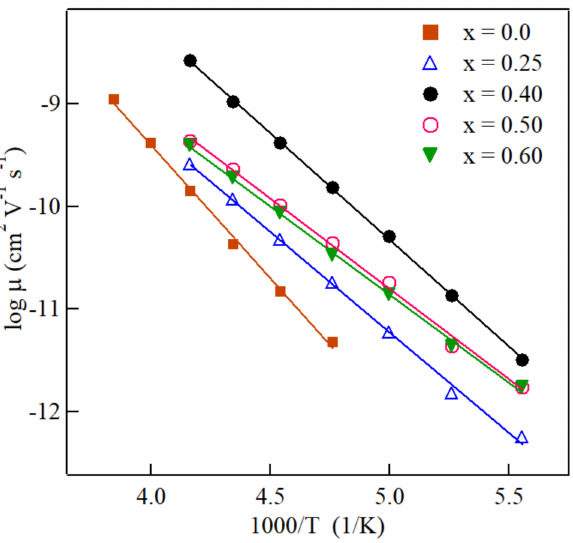
Figure 5. The temperature dependence of the mobility of Li + ions in different LLN-Sm ceramics, as estimated by Equation (4).